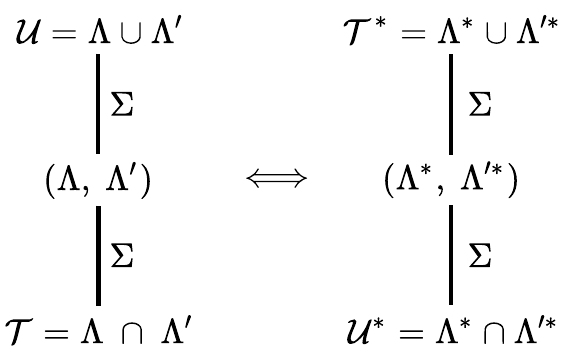
Figure 2. Tree of the partial order of the translation groups T α , Λ , Λ (cid:48) = α Λ α − 1 and U α in direct and reciprocal spaces (see [13]). The order sequence goes from T α being a subgroup of Λ ( Λ (cid:48) ) of order Σ and Λ ( Λ (cid:48) ) being a subgroup of U α of same order. This corresponds in reciprocal space to exchanging the roles of T α and U α : T ∗ α is the union of the reciprocal lattices and U ∗ α is the intersection of the reciprocal